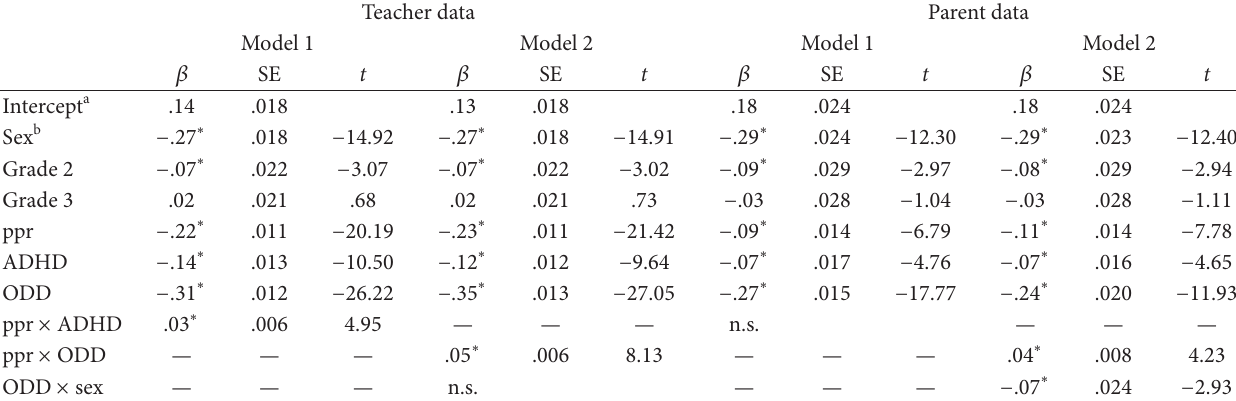
T 2: Results of the regression analyses with prosocial behavior as the dependent